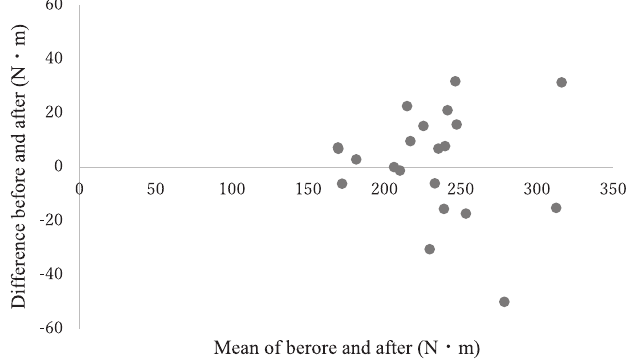
Figure 12 Bland-Altman graph showing each of the estimated maximal isometric torques before and after modification of the leg extension machine (Test 1: average angular velocity and average torque).